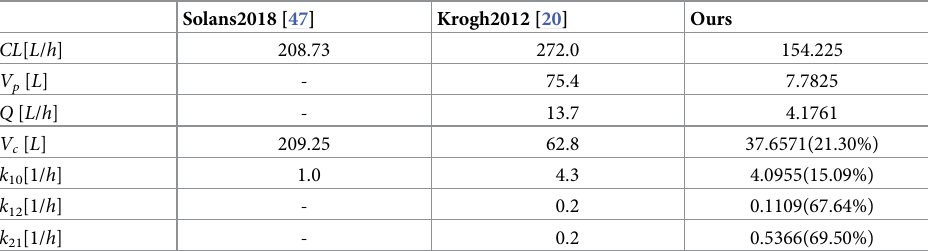
0.5366(69.50%) Final parameter estimates and relative standard errors (in brackets) are shown. Comparing our model with a published two-compartment model for low-dose Ara-C [20], we estimated a smaller central volume leading to a reduced clearance activity derived from an almost equivalently estimated elimination rate constant value. The distribution rate constants differ by a factor of 2 to 2.5 and the peripheral volume by a factor of almost 10. The parameter values and the visual assessment of the one-compartment model [47] in S8 Fig indicate, that the one- and two-compartment models describe Ara-C concentrations with qualitatively different